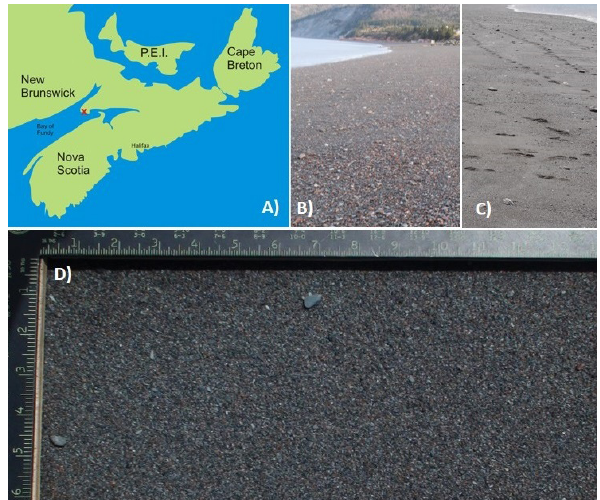
Figure 1. (a) The location of Advocate Harbour at the Bay of Fundy between Nova Scotia and New Brunswick, Canada. (b) Photograph of the beach face at low water during calm weather conditions. (c) Photograph of the beach face at low water after a storm event. (d) Photograph of the surficial sediments after a storm event (scale in inches).